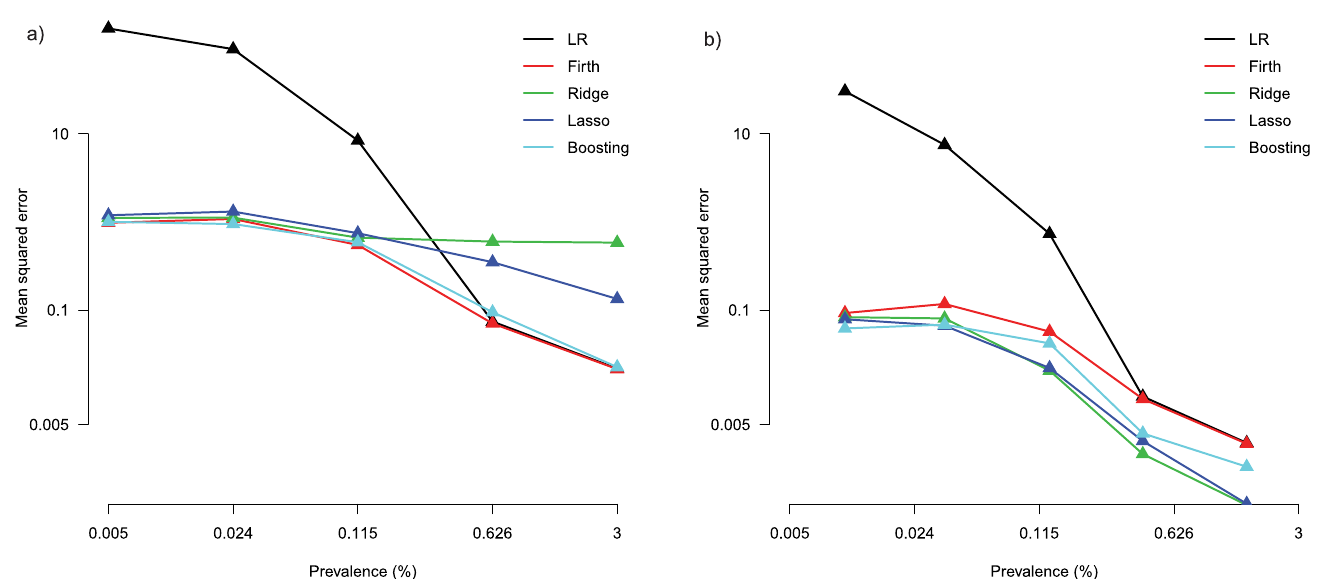
Fig 3. Simulation data. (a) Mean squared errors across the 5 relevant variables. ( b ) Mean squared errors across 5 groups of irrelevant variables (9 variables per group). All axes are on a logarithmic scale.